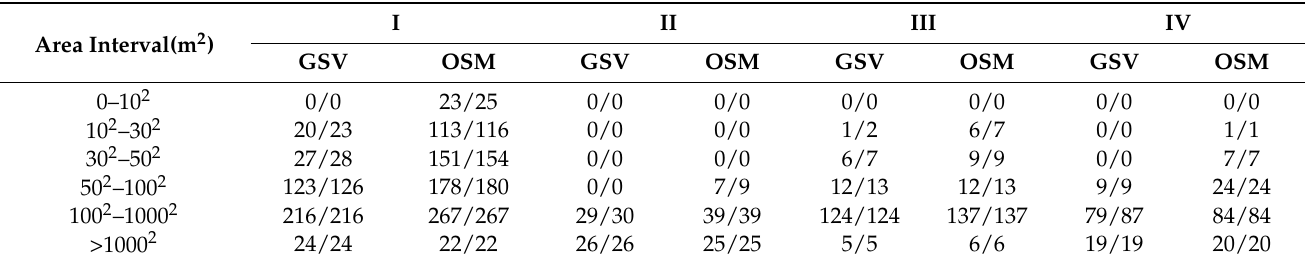
Table 3. The reliability of islands in the two datasets (GSV and OSM), in consideration of different area intervals *.